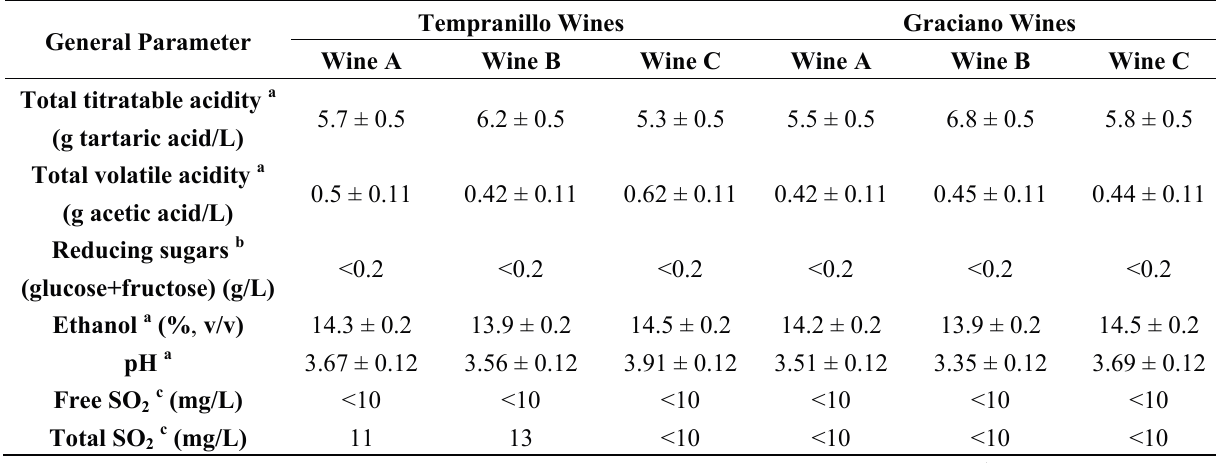
Table 4. General parameters of Tempranillo and Graciano final